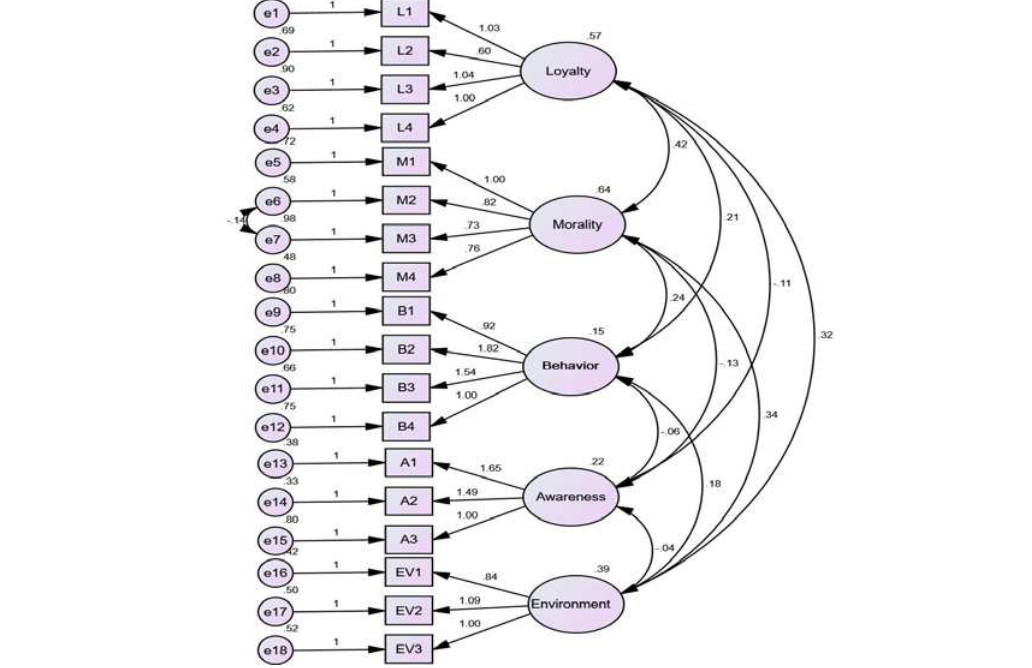
Fig. 2. Confirmatory Factor Analysis